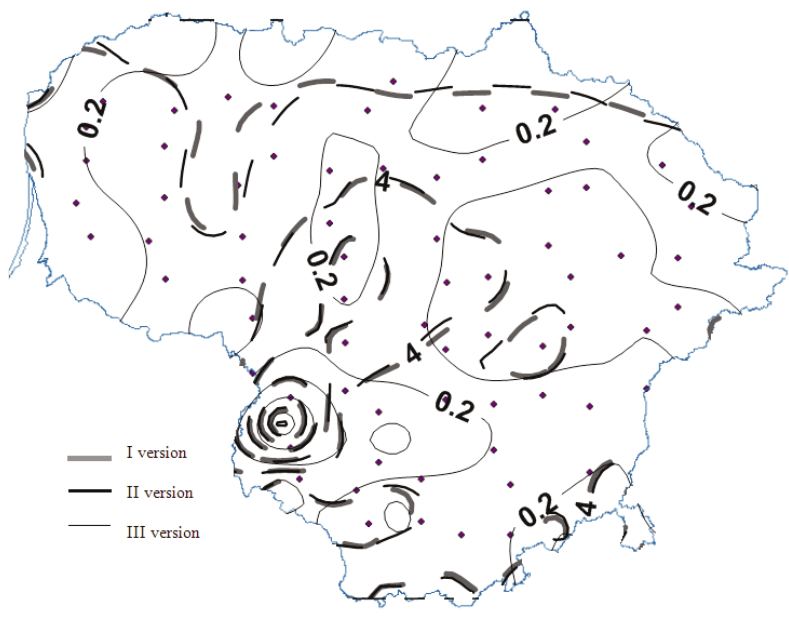
Fig. 2. The isogram of the maximum related elongation